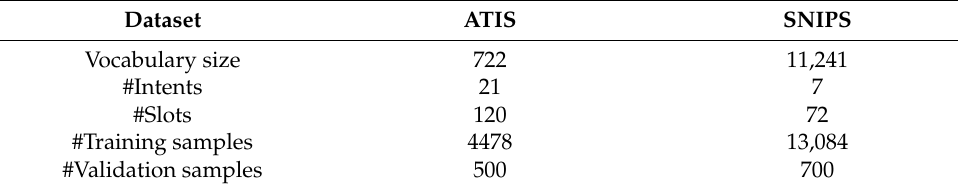
Table 3. Specific statistics of the two